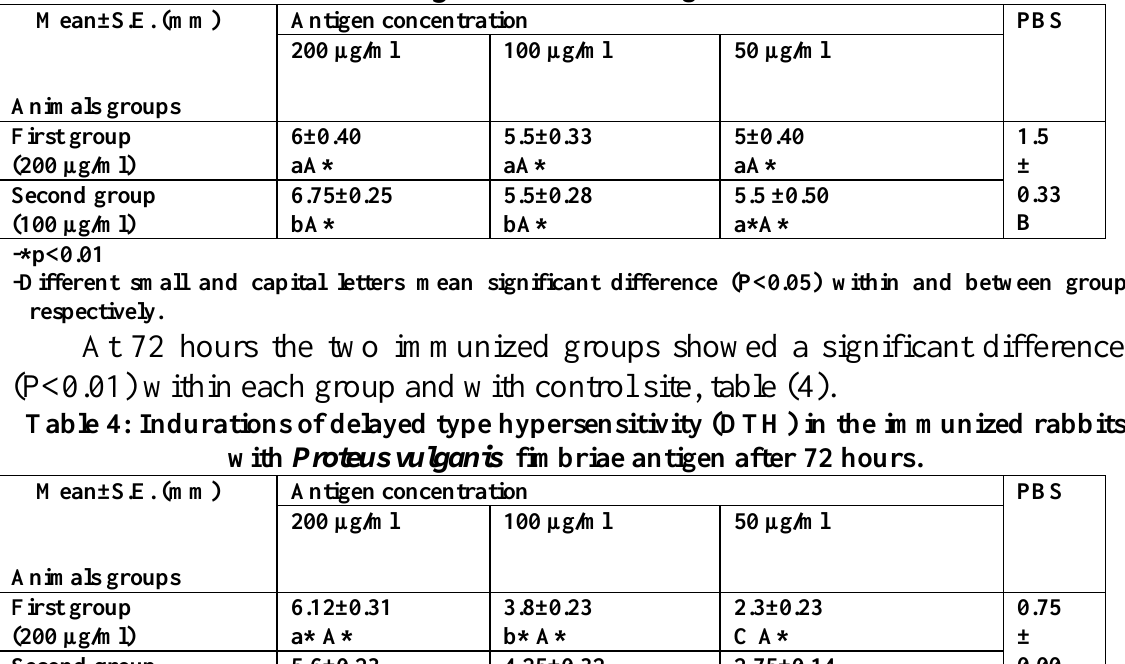
Table 3: Indurations of delayed type hypersensitivity (DTH) in the immunized rabbits with Proteus vulganis fimbriae antigen after 48 hours.